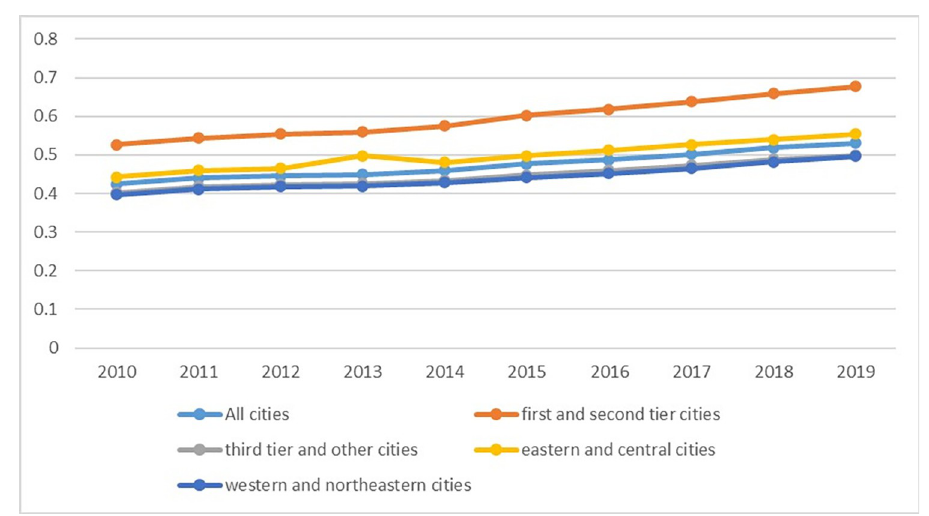
Fig 4. Cities’ degree of coordination of the digital economy, industrial structure supererogation and pollution